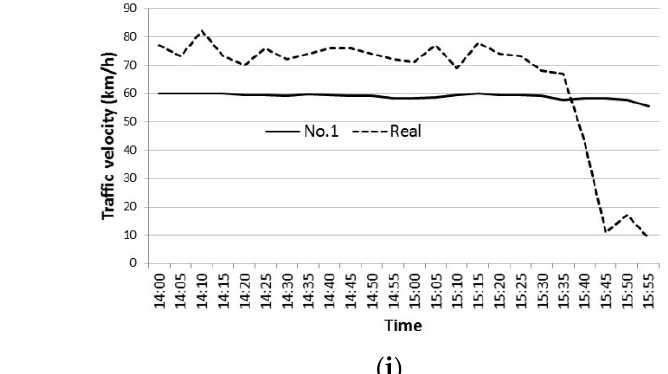
Figure 7. Comparing loss time (No.1 and real data).